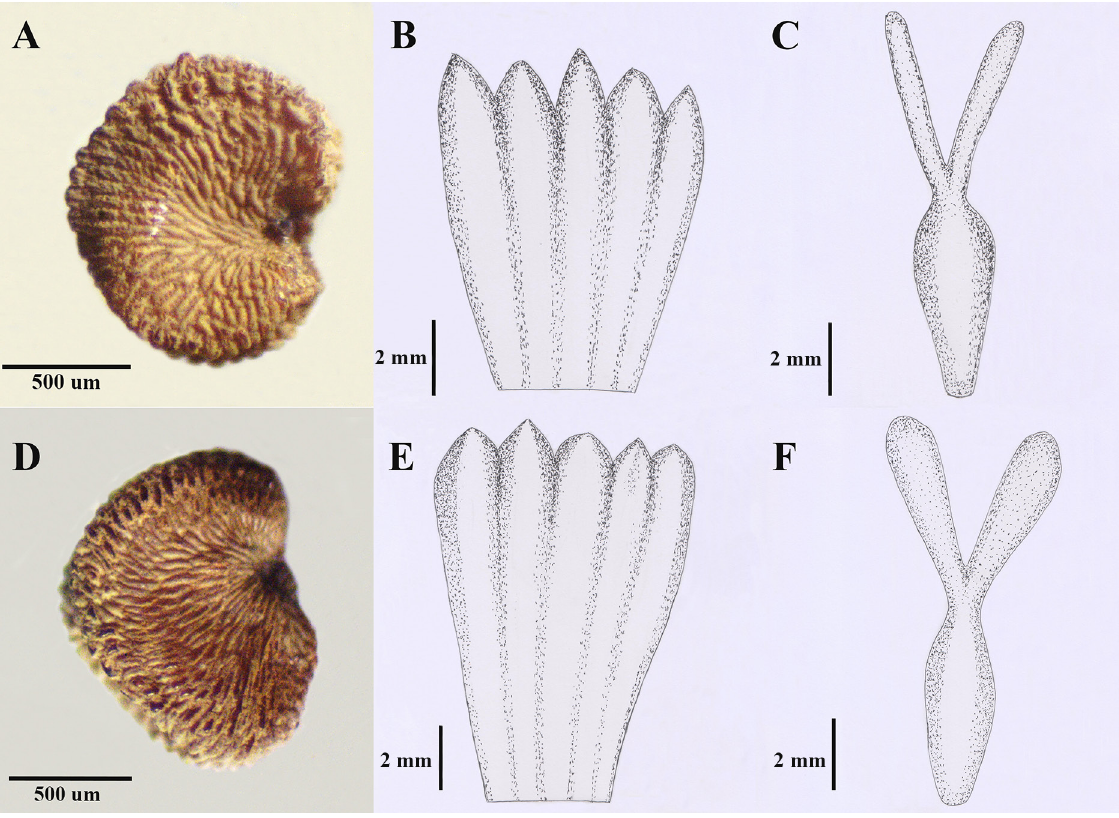
Fig. 6. A–C . Silene thyrsiantha F.Jafari, Mirtadz. & Keshavarzi sp. nov. ( M. Mirtadzadini 2089 ;